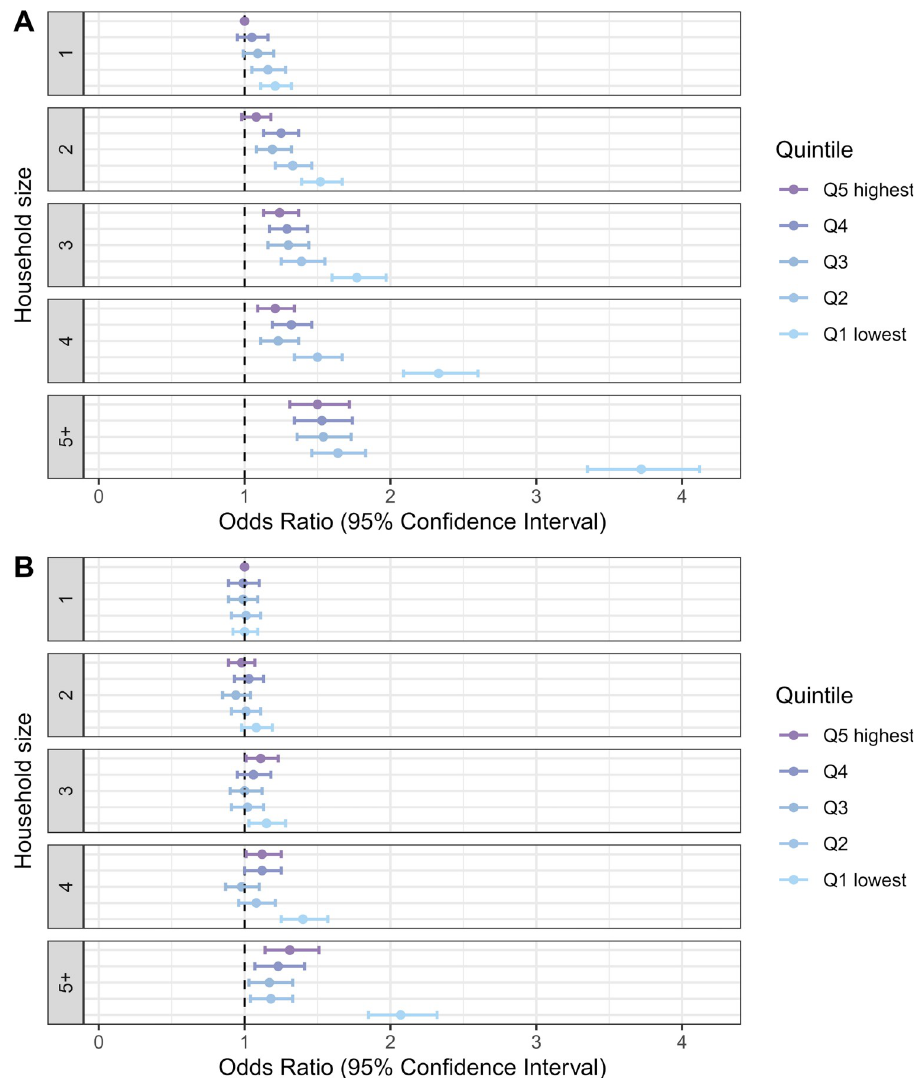
Fig 5. Odds ratios of COVID-19 incidence by household income quintile and household size. In under-65 households (A) adjusted for age and age squared, sex, and regional characteristics; (B) adjusted for age and age squared, sex, regional characteristics, household-level work and school exposures, and foreign